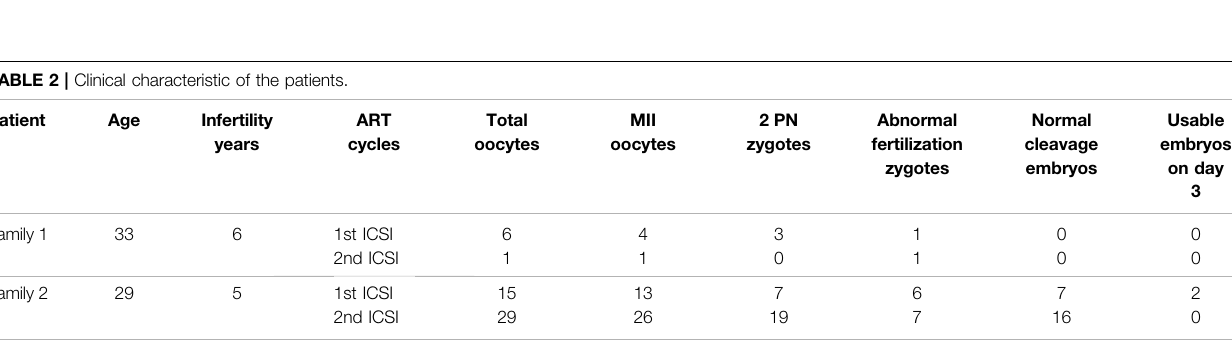
TABLE 2 | Clinical characteristic of the